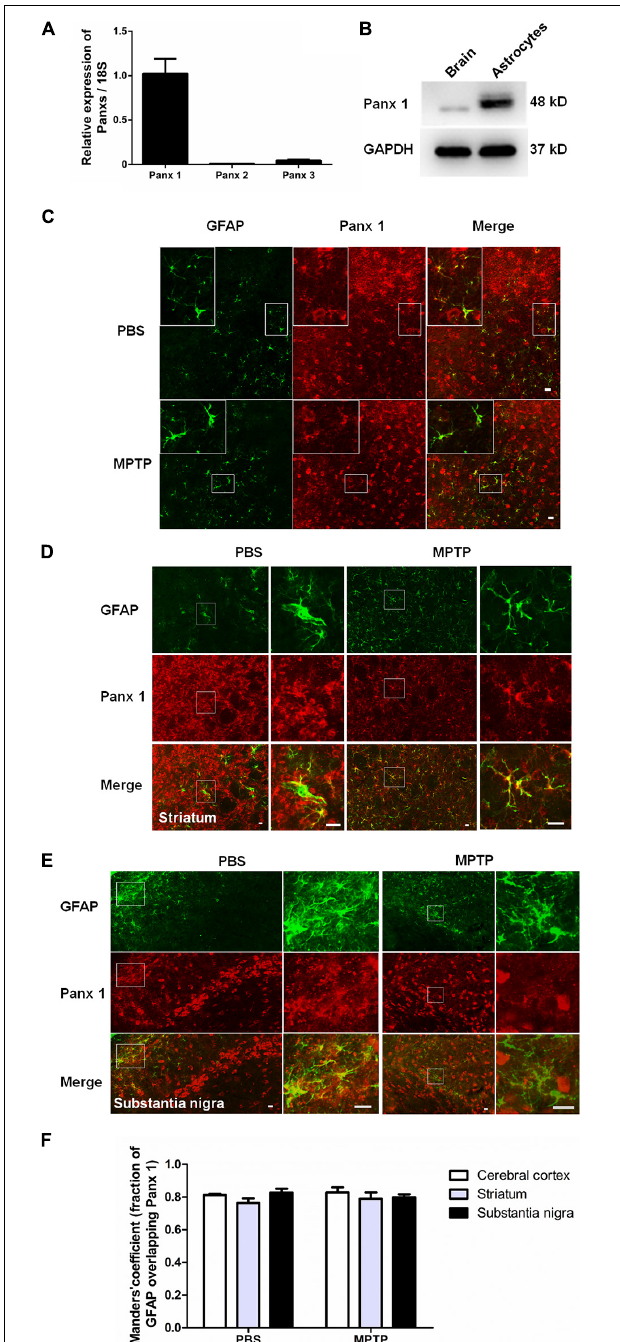
FIGURE 1 | Characterization of Panx 1 expression in astrocytes. (A) qPCR analysis of Panx 1, Panx 2, and Panx 3 mRNA levels in cultured primary astrocytes normalized to 18S mRNA levels. (B) Panx 1 protein levels in cultured primary astrocytes was measured by Western Blotting and the brain was used as a positive control. (C–E) Panx 1 immunostaining in the cerebral cortex, striatum and SN in wild type mice after injection with PBS or MPTP on 4 days. Enlarged images are from the inset box. The sections were double-stained with Panx 1 (red) and GFAP (green). (F) Manders’ coefficient of the fraction of GFAP overlapping Panx 1 in the cerebral cortex, striatum and SN. Scale bar, 20 µ